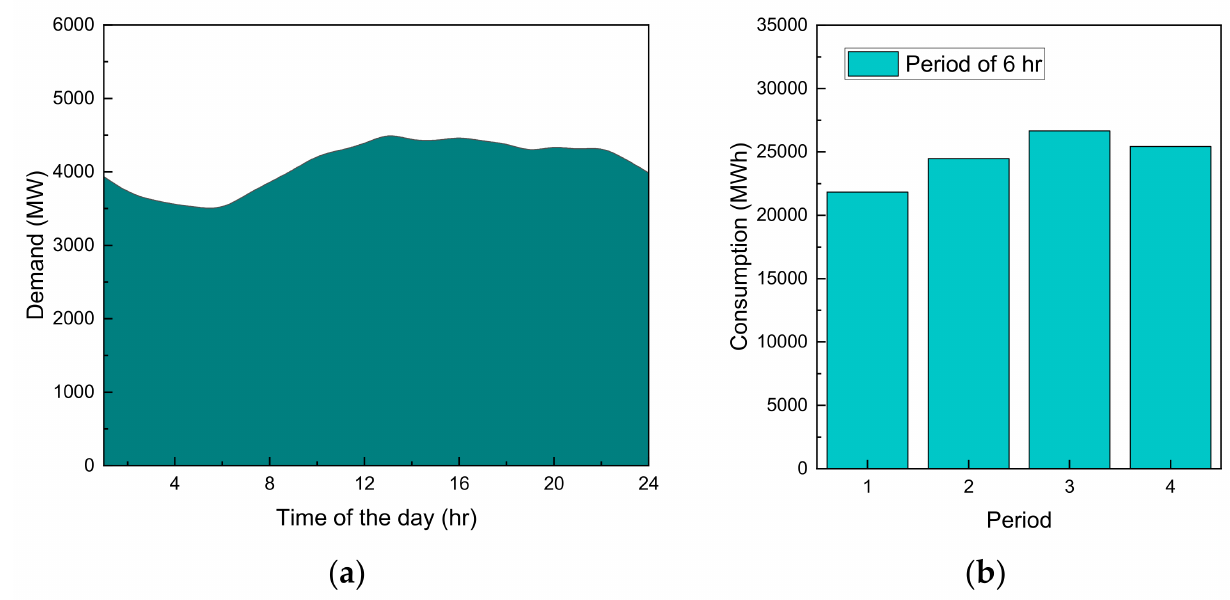
Figure 3. The behavior of demand in the Eastern Zone. ( a ) The corresponding demand in the Eastern Zone per hour. ( b ) Consumption accross periods of 6 h.